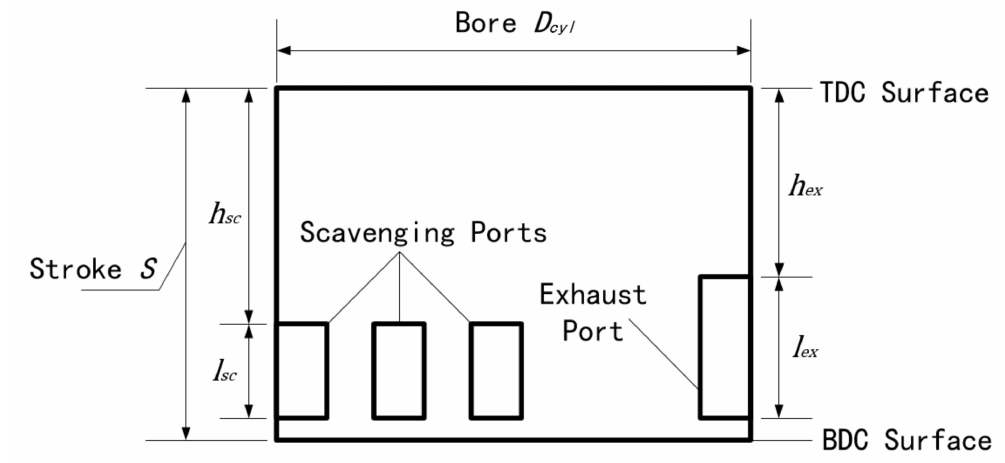
Figure 20. A sectional drawing of the engine